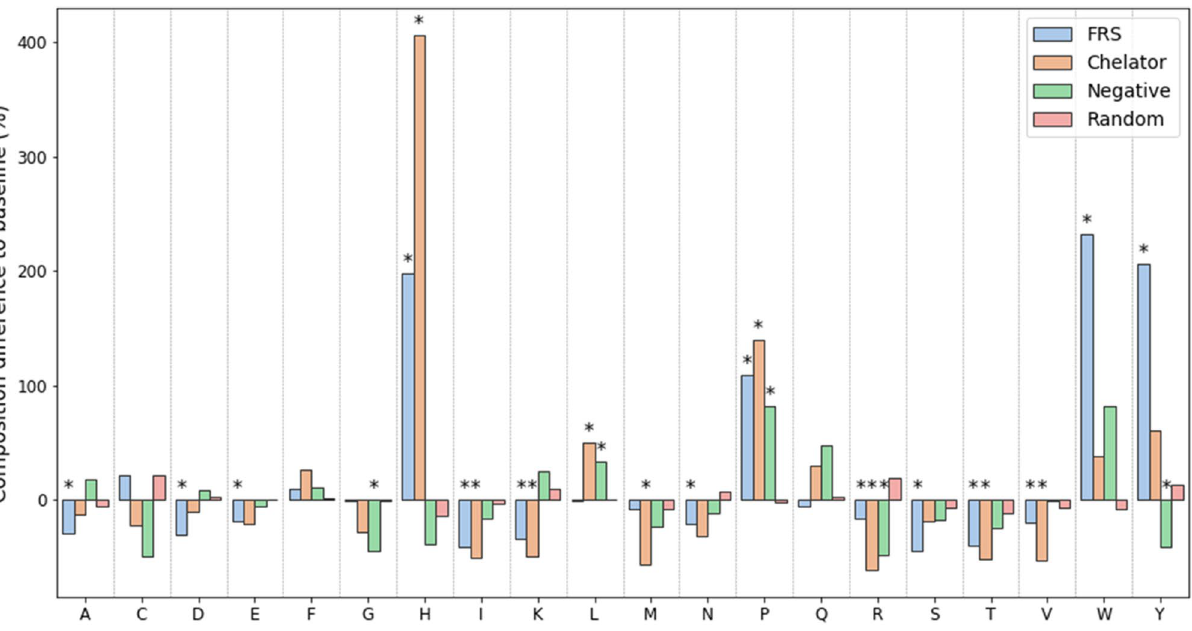
Figure 3. The difference in composition between the antioxidant dataset and a baseline (the average amino acid composition in the UniProtKB/Swiss-Prot data bank). Significant differences (P value < 0.05) was determined by applying a one sample test of proportions 59 for each amino acid and was marked with an asterisk (*). FRS Free Radical